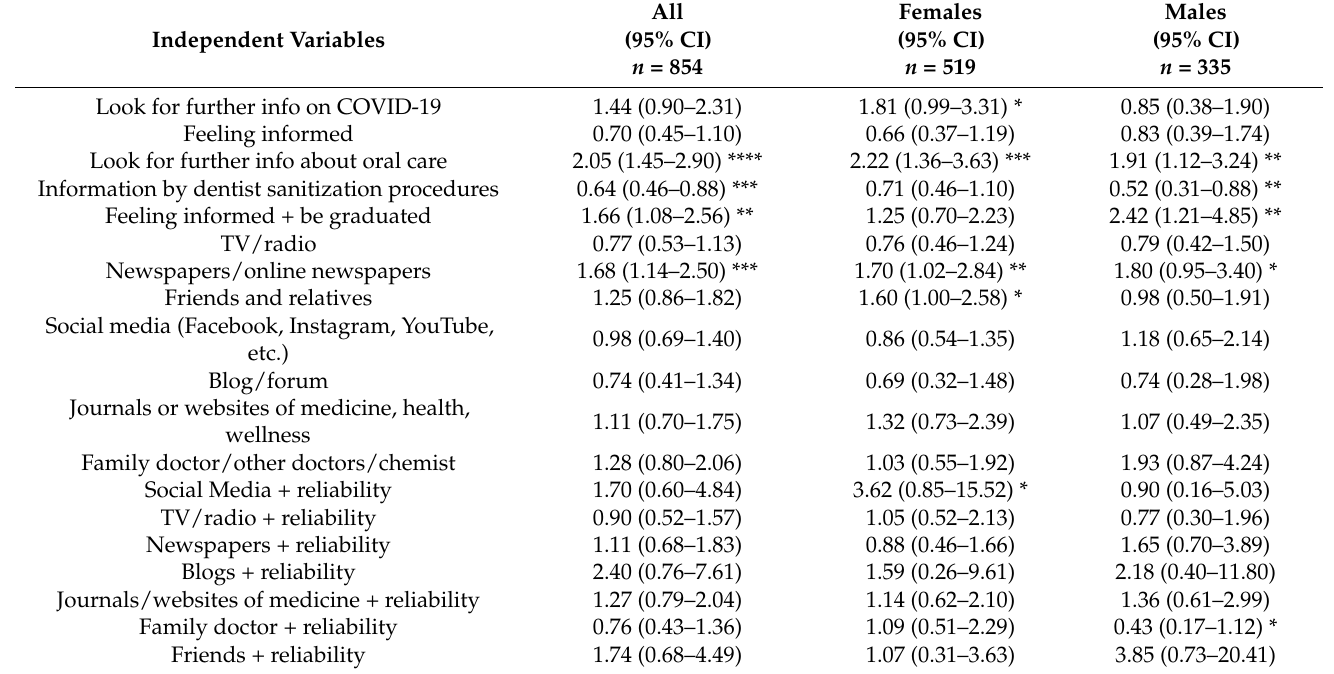
Table 1. Odds ratio estimates of variables associated with influence of COVID-19 on upcoming dentist appointments (* p -value < 0.10, ** p -value < 0.05, *** p -value < 0.01, **** p -value <